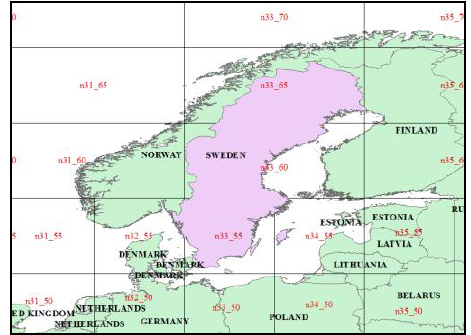
Figure 9. The geographic location of test site in the accuracy test. Light purple area outline the area of Sweden, which also shows that Sweden consists of seven map